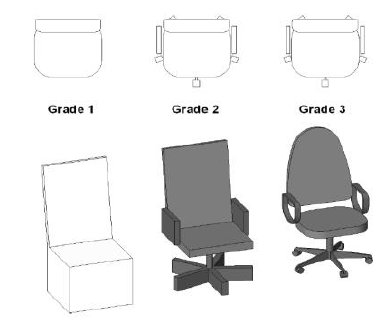
Figure 7. Representation of three levels of detail, referred to as component grades (AEC (CAN) BIM Protocol, 2012).